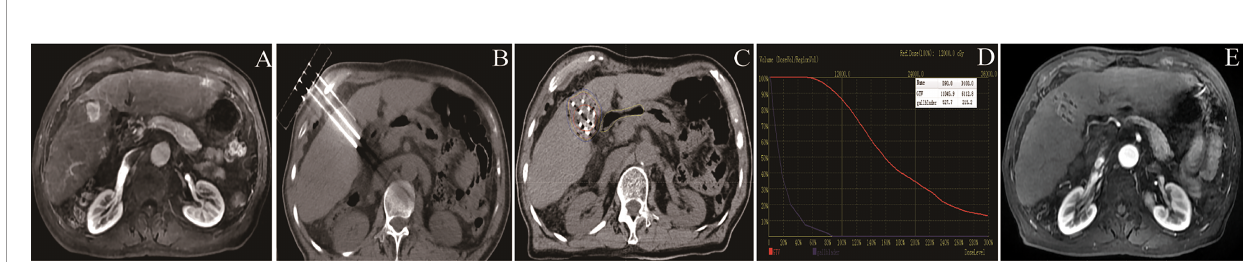
FIGURE 1 | Flow chart showing the seeds implantation procedure: (A) Tumor in the right liver; (B) 3D ⁃ printing coplanar template-guided intraoperative needle insertion; (C) seeds implantation and postoperative dose veri fi cation; (D) the dosimetric parameters, e.g. D90, D100 were identi fi ed. (E) ef fi cacy observation of postoperative follow-up at 6